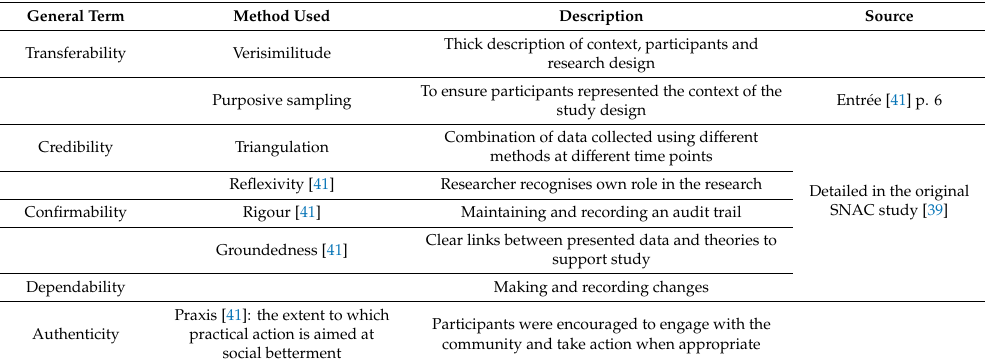
Table 3. Measures of